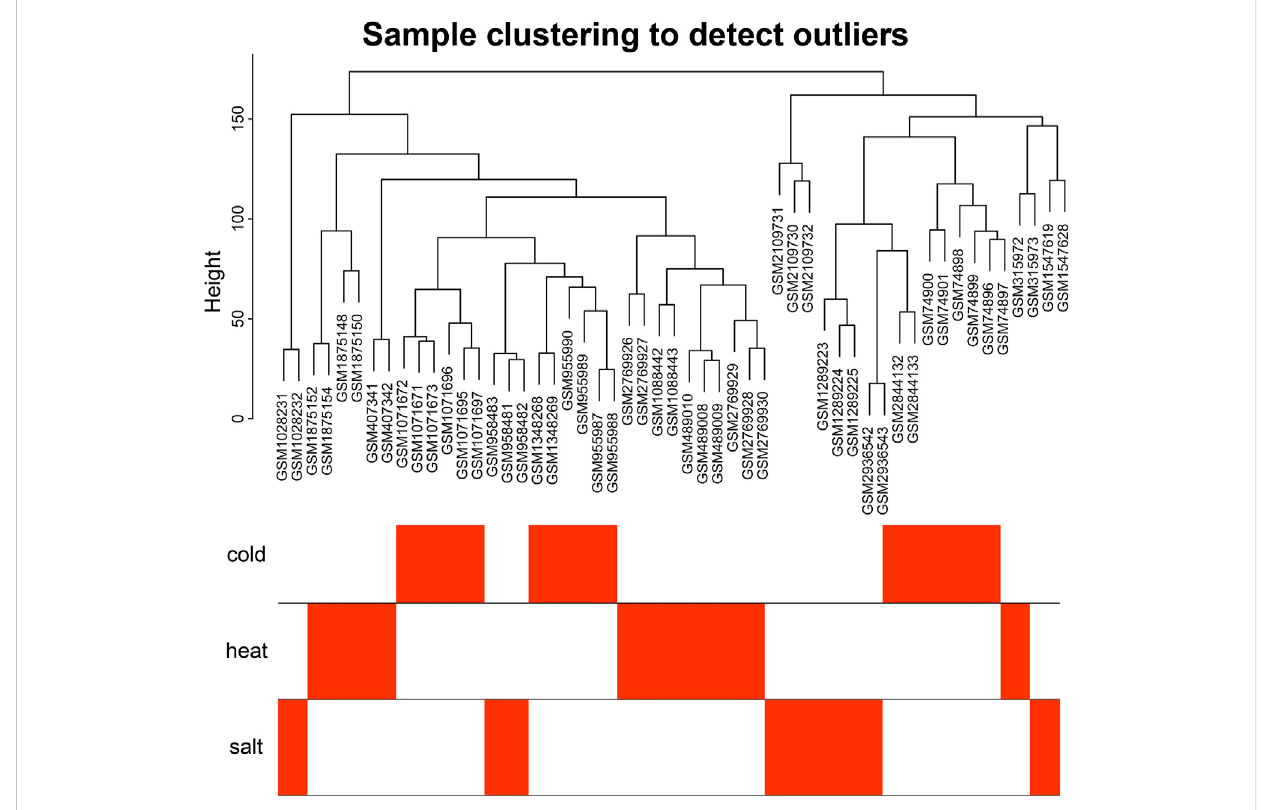
FIGURE 1 Sample cluster analysis diagram. Sample clustering analysis showed that no samples were outliers.